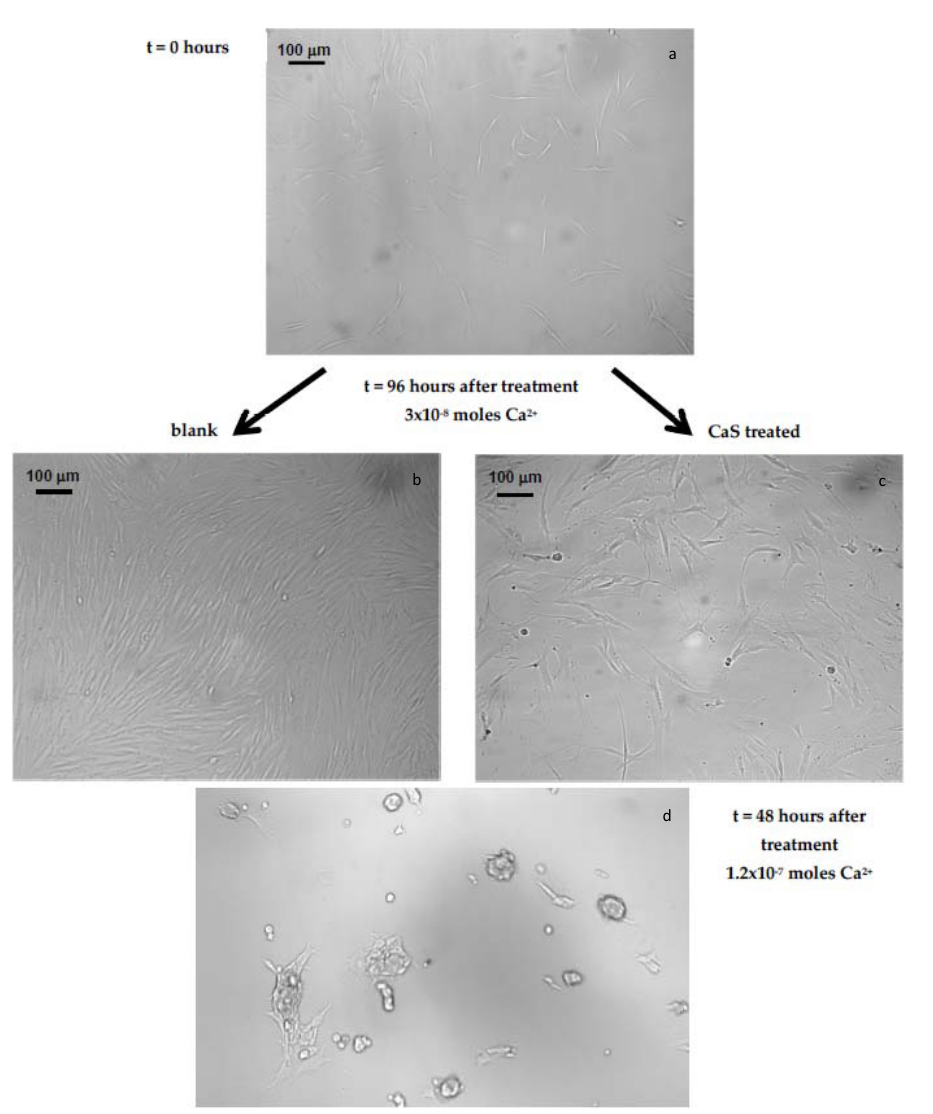
Figure 3. Images of adenocarcinoma cells obtained: ( a ) 24 h after inoculation, ( b ) the control 96 h after preparing the culture, and ( c ) 96 h after adding a single dose of CaS NS. The amount of Ca 2+ in the NS dispersion is 4 × 10 − 8 moles. ( d ) A representative image of adenocarcinoma cells 48 h after a dose of CaS NS with a Ca 2+ ion content of 1.2 × 10 − 7 mol is indicated at the bottom of the figure. Human carcinoma cells, on the other hand, treated with 500 µ L of CaS nanocluster dispersion exhibited a decreased ability to properly enter the cell cycle marked by a decrease in cell concentration in the G0/G1 phase at 24 hours post-treatment and then an increase in cells held in the SubG1 and G0/G1 phases up to 72 h post-treatment. We did not observe any statistically significant differences in the cell population in the S or G2/M phases, suggesting that CaS nanoclusters’ main mode of action in the first 24 and 48 h is centered around early cell cycle